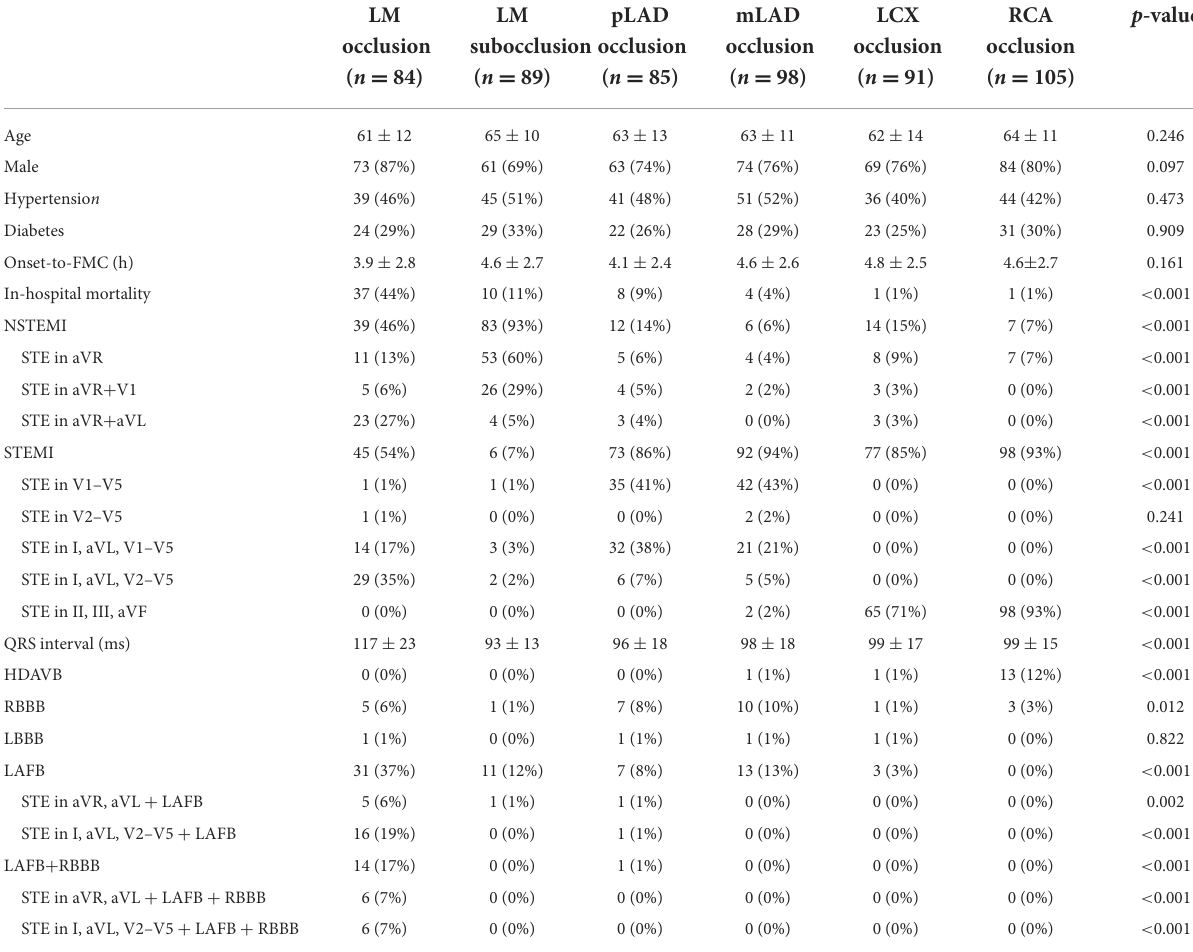
TABLE 1 Comparison of baseline characteristics and ECG findings in different